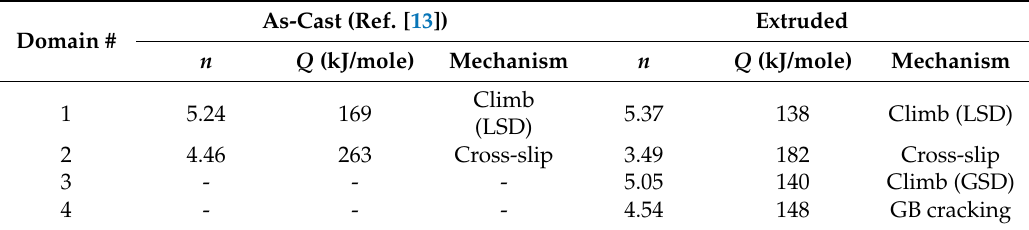
Table 2. The kinetic parameters, namely the stress exponent ( n ) and apparent activation energy ( Q ), in the various domains of the processing maps for the ABaX422 alloy, and the proposed rate-controlling mechanisms in the as-cast and extruded